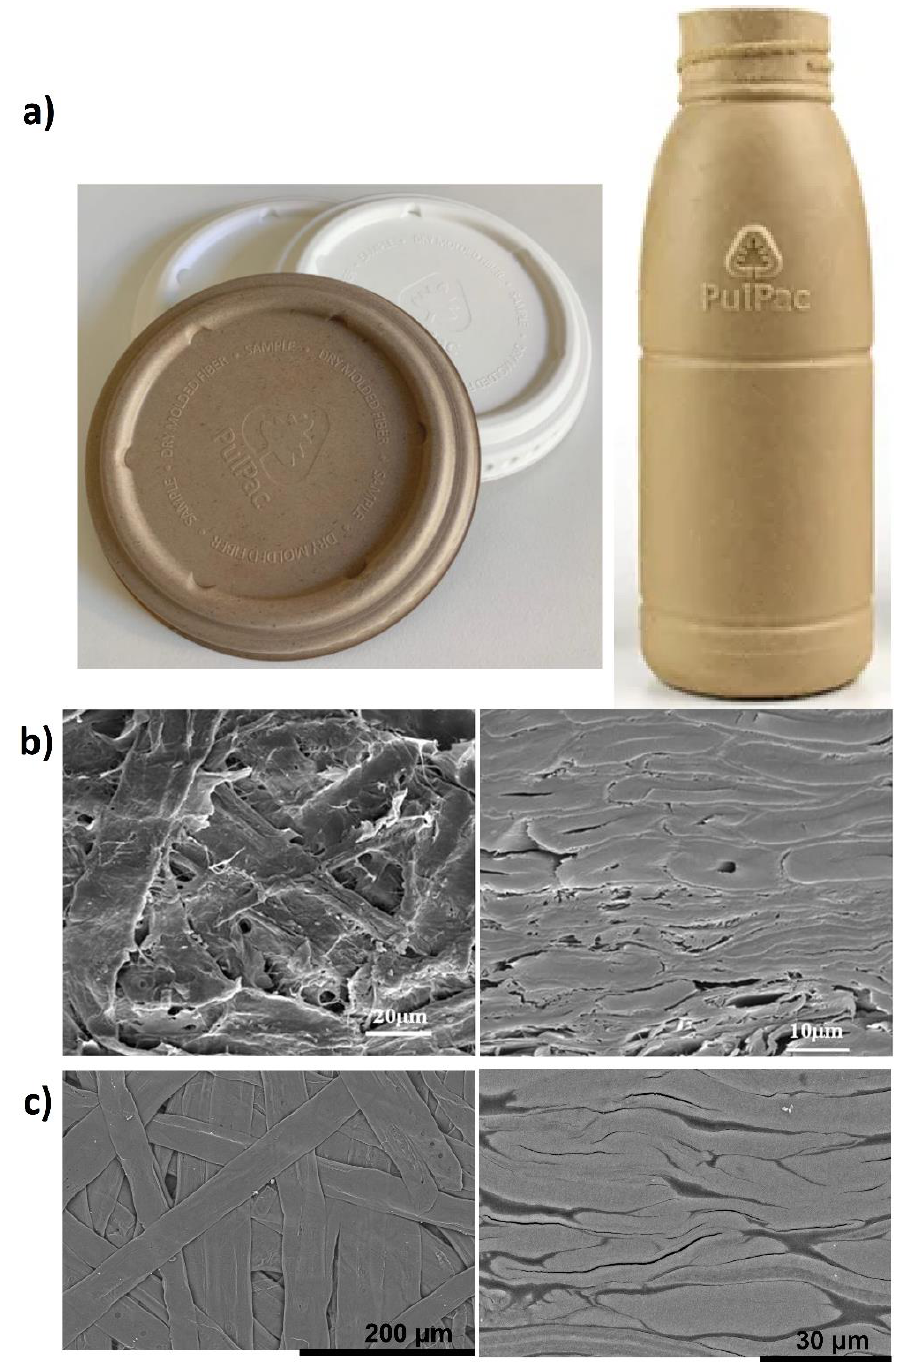
Figure 1. ( a ) Examples of molded pulp products in the form of lids to coffee cups and bottles [39]. Top and cross-sectional SEM images of hot-pressed molded fibers from ( b ) mildly delignified TMP fibers [32] or ( c ) unbleached kraft fibers [14]. ( a ) Reprinted with permission from PulPac AB [39] ( b ) Adapted with permission [32], Copyright 2018, Springer Nature. ( c ) Adapted with permission